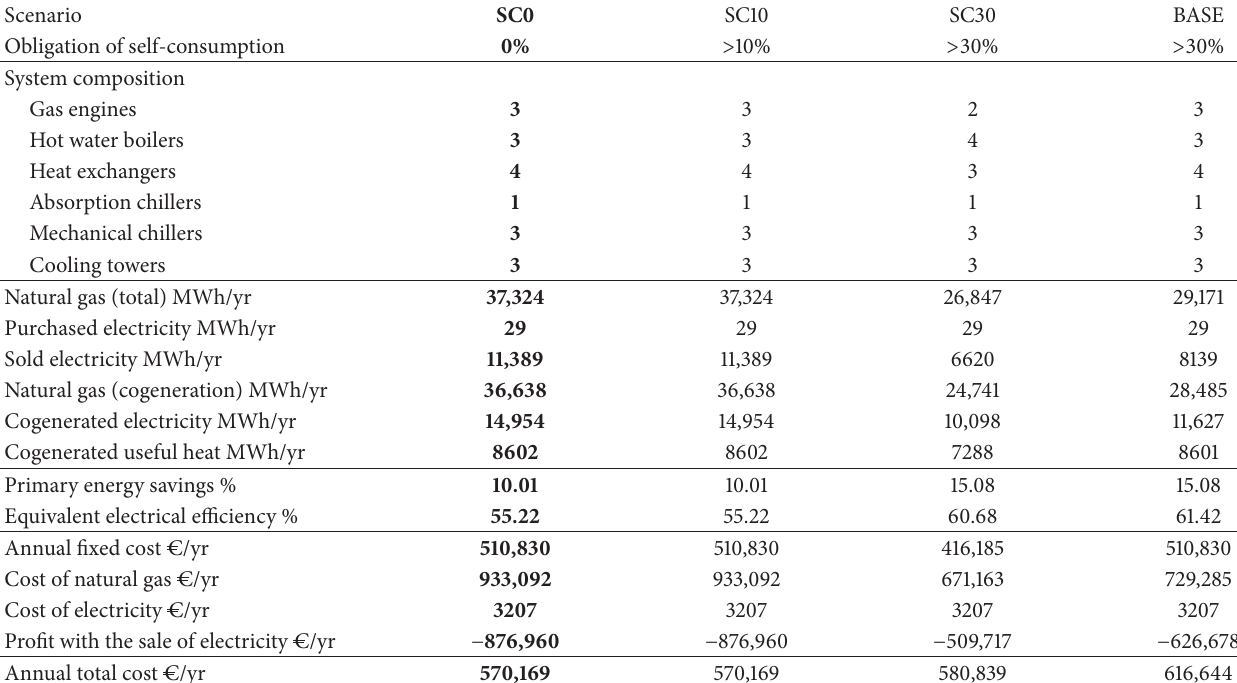
Table 9: Sensitivity analyses for legal constraints on mandatory